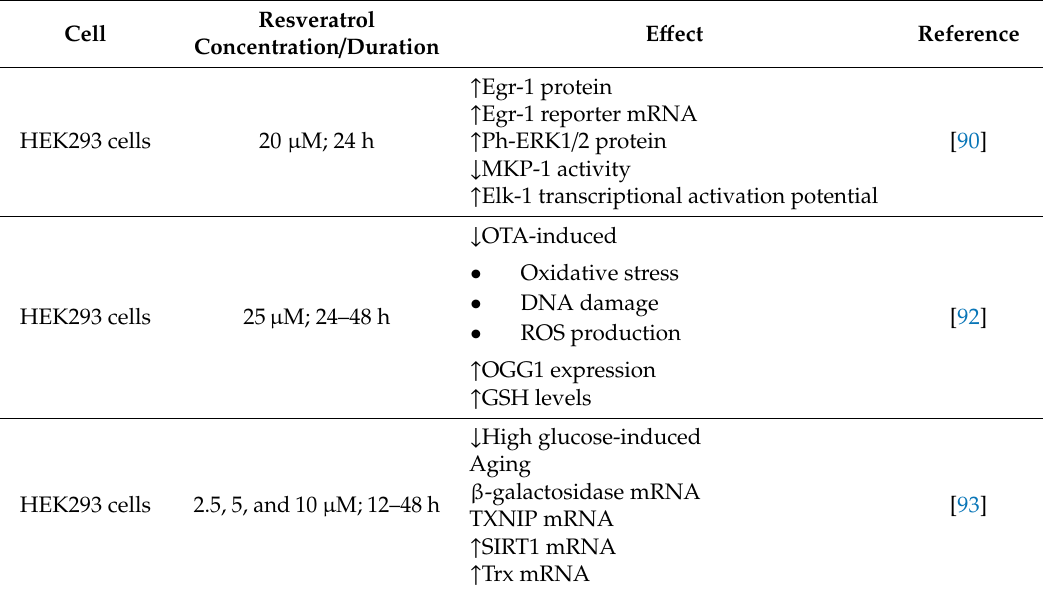
Table 4. E ff ects of resveratrol on embryonic kidney